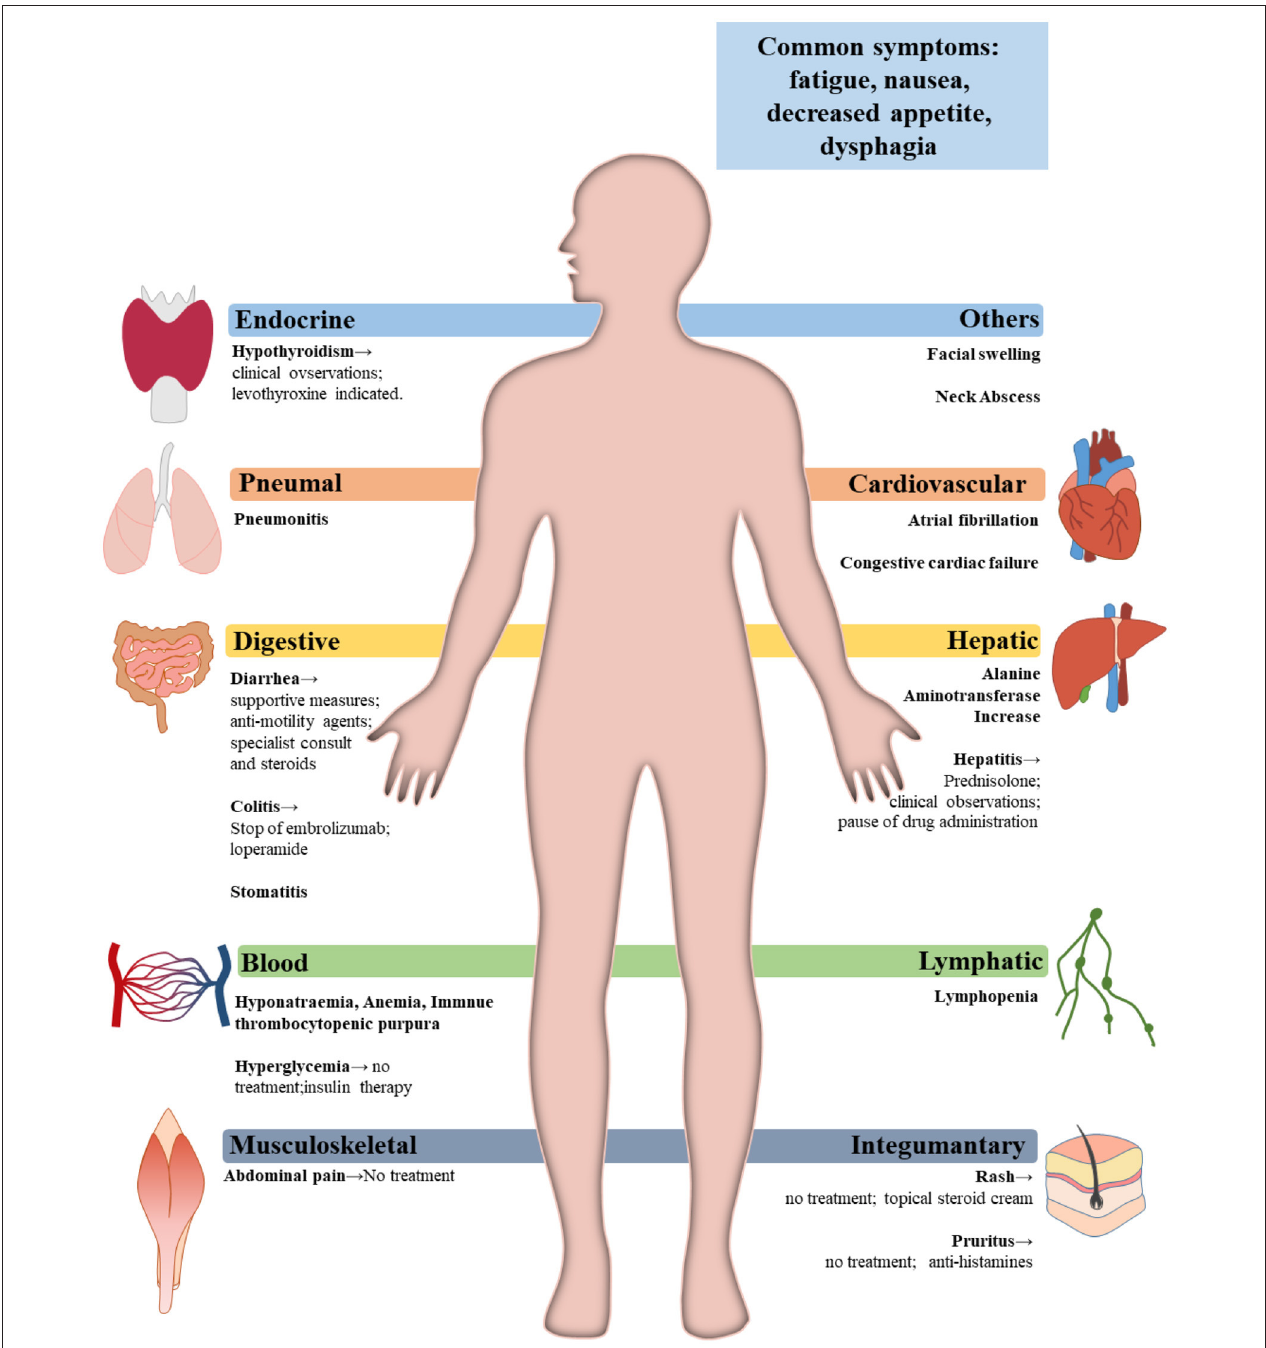
FIGURE 3 | Main adverse events and treatments.